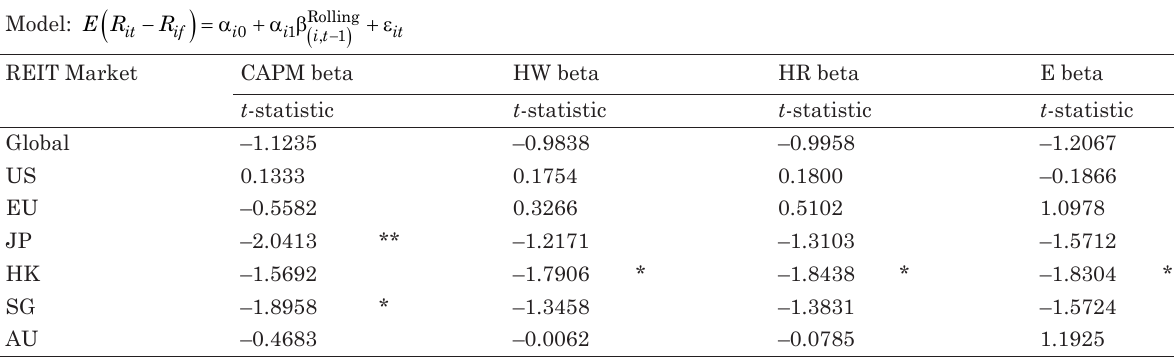
Table 8. The relationship between the rolling betas and the expected REIT return